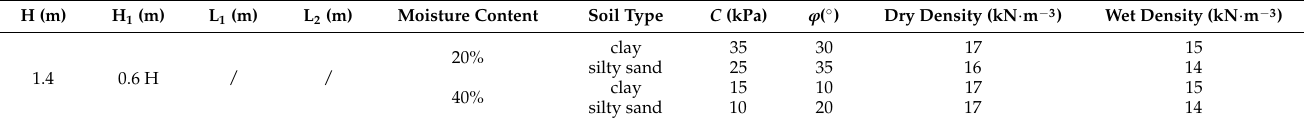
Table 4. Model parameters for simulating the effect of the scour degree on the stability coefficient.